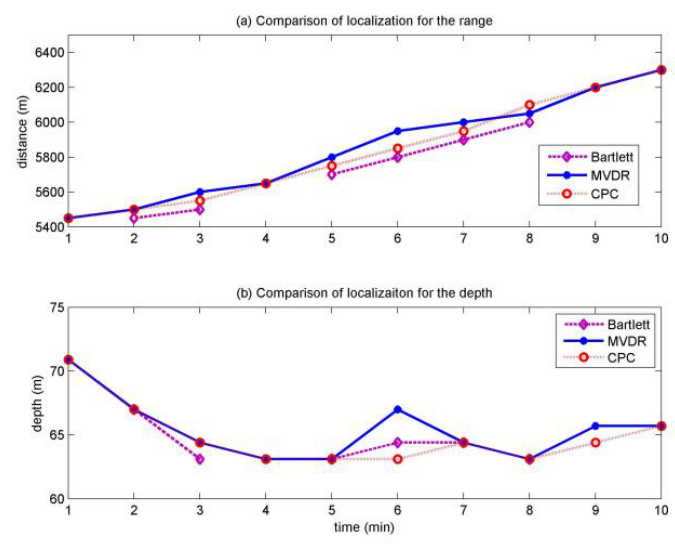
Figure 9. Tracking of the moving source in the whole 10 min.